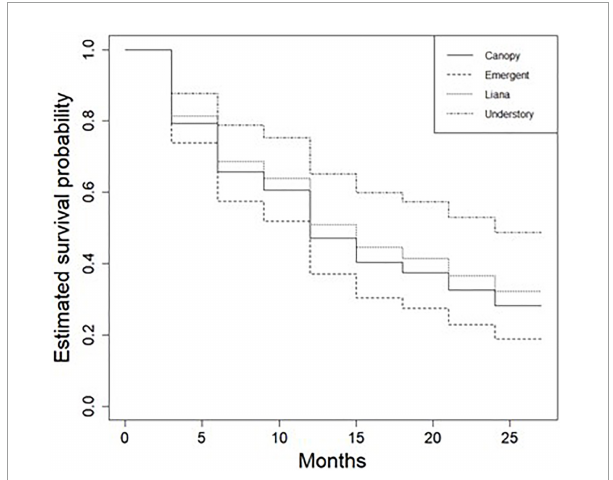
FIGURE5 Estimated survival probabilities of seedlings across growth form guilds in the Ngel Nyaki Forest Dynamics Plot from January 2018 to January 2020. The lines represent estimated survival average probabilities for the different groups. The survival functions were calculated using the Kaplan–Meier method.